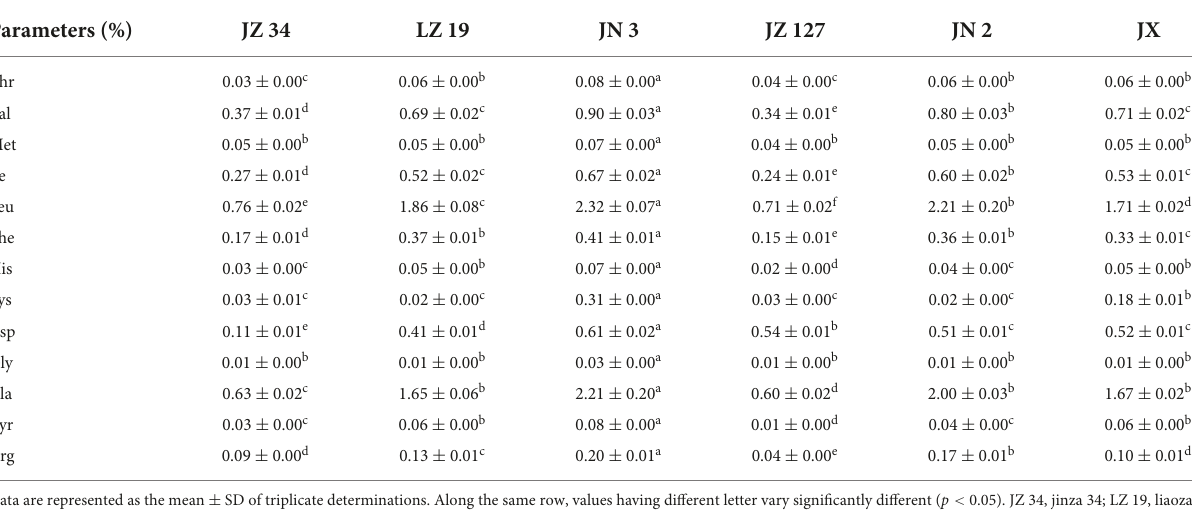
TABLE 6 Amino acids compositions of different sorghum grains.